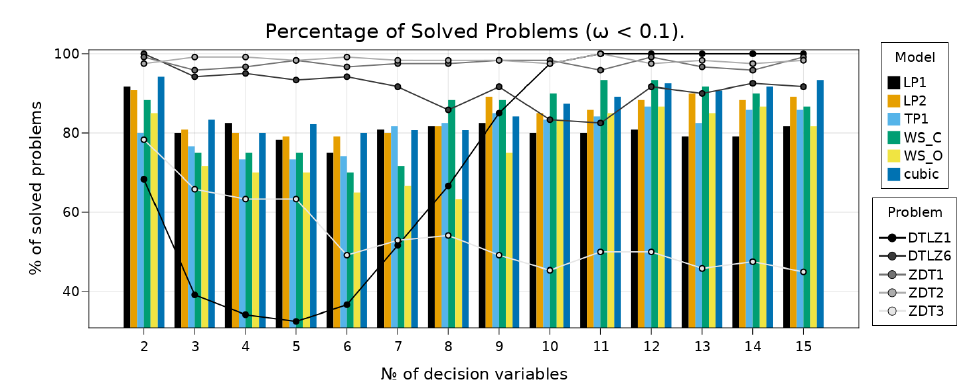
Figure 5. Each group of bars shows the percentage of solved problem instances, i.e., test runs were the final solution criticality has a value below 0.1. From left to right, the bars correspond to the Trust Region Method (TRM) using linear Lagrange polynomials, the TRM with quadratic Lagrange polynomials, TRM with linear Taylor polynomials, weighted sum with COBYLA , weighted sum with ORBIT and TRM with cubic RBF. Per model and n -value there were 60 runs.